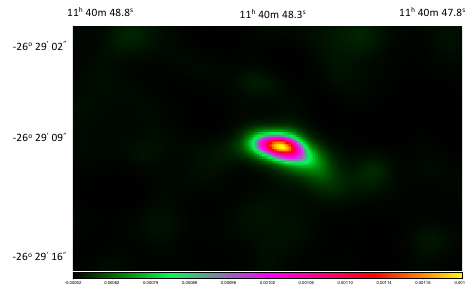
Figure 2. Preliminary analysis of the combination of the ALMA ACA and 12m arrays of the CO(4-3) lines (Souvaitzis et al, in